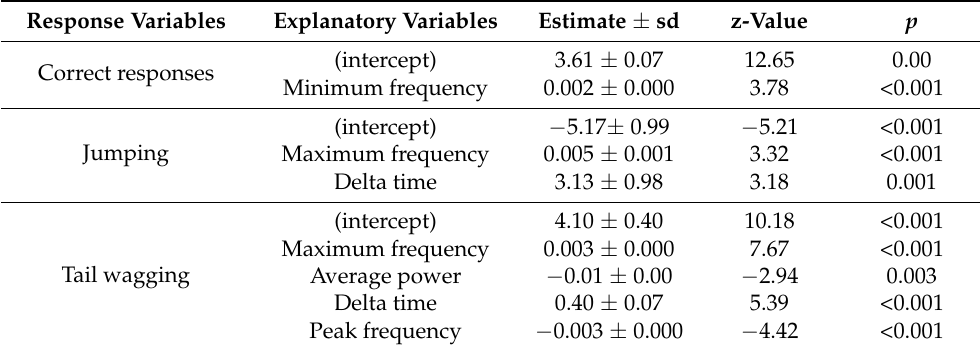
Table 8. Final Generalized Linear Mixed Models * run for dogs ( Canis familiaris ), analyzing the effects of the variables minimum frequency; maximum frequency; delta time; average power; peak frequency on the response variables correct responses; jumping; and tail wagging.